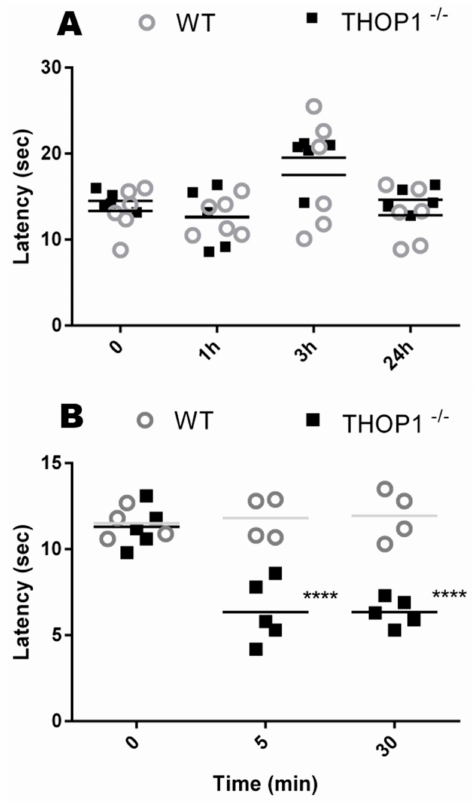
Figure 5. Hot plate test. (A) Regular basal nociceptive response of THOP1 - / - or WT litter mates, evaluated by the hot plate test at di ff erent time points. Note that THOP1 - / - latency to nociceptive stimulus is similar to WT at this determined dose of BK (0.1 µ M; 40 µ L). Data are expressed as mean ± SEM of 4–6 animals per group. Data were analyzed by two-way ANOVA followed by Bonferroni’s multiple comparison test. ( B) Nociceptive response was evaluated after Bk was injected intraplantar (0.1 µ M; 40 µ L). Note that THOP1 - / - latency to nociceptive stimulus is significantly lower than that of WT. Data presented as mean ± SEM. Data were analyzed by two-way ANOVA followed by Bonferroni’s multiple comparison test. **** p < 0.001 compared to either control (0 min) or to WT (after 5 or 30 min of Bk intraplantar